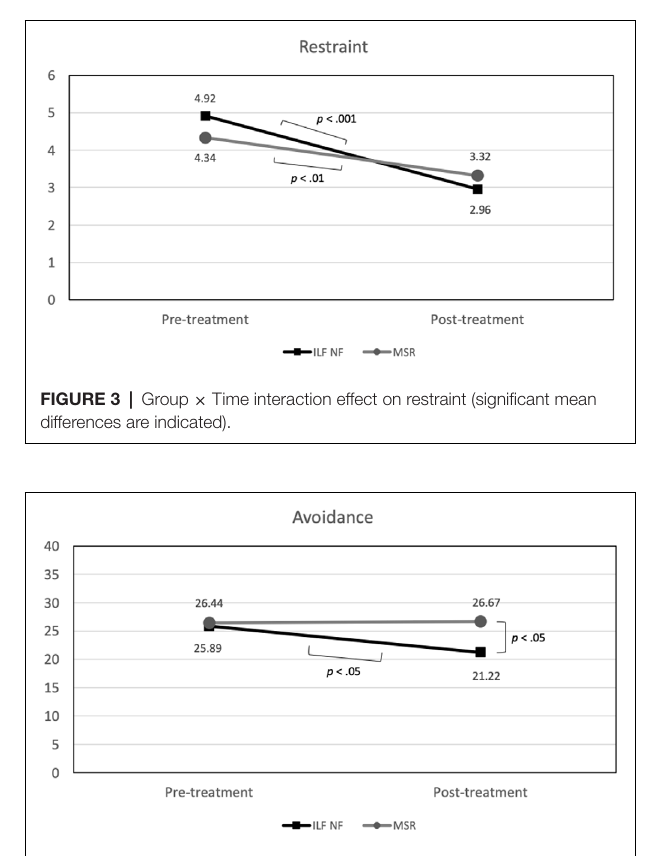
lower (mean 25.78; std.dev. 5.82) than at pre-treatment